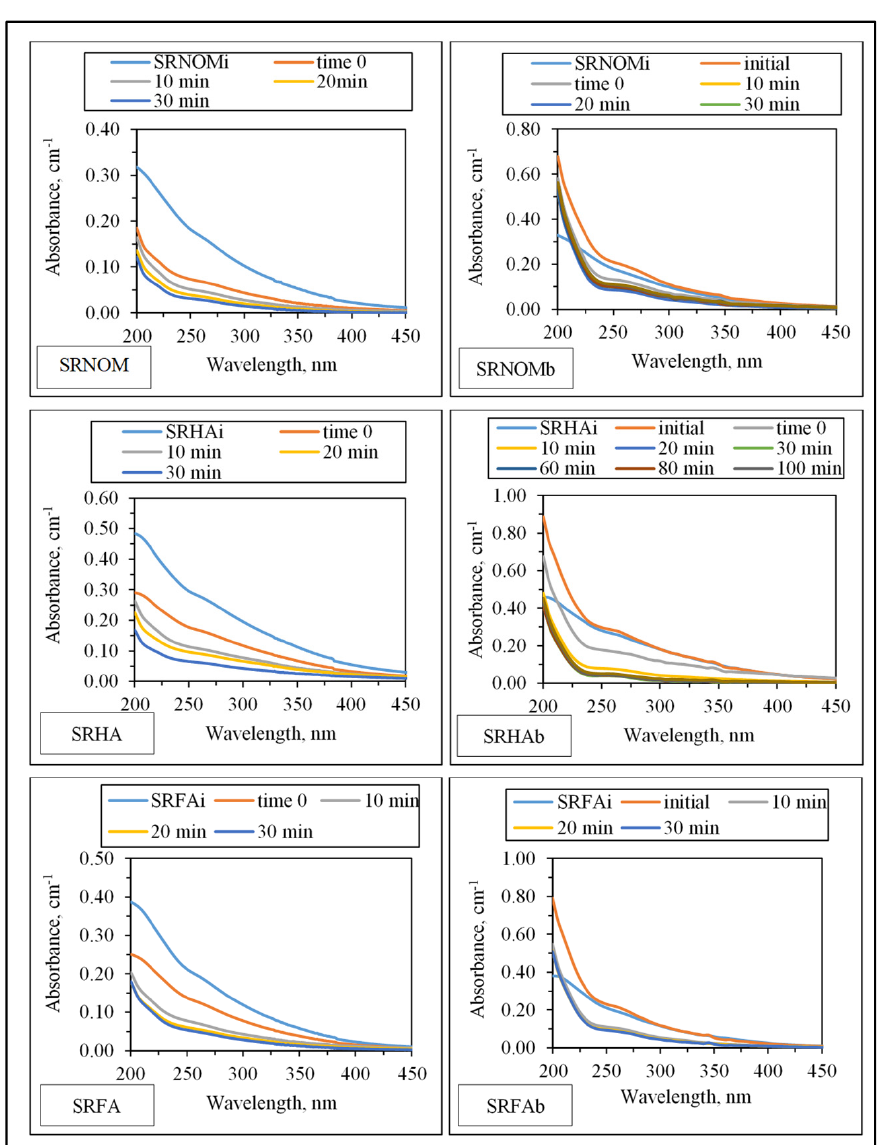
Figure 3. UV-VIS absorption spectral features of the organic matrix upon solar photocatalytic degradation of NOM compounds in the absence/presence of E. coli (b denotes the presence of bacteria). Insignificant absorbance values for λ > 400 nm indicated the absence of chromophoric groups (color-forming moieties) related to the presence of systems including conjugated double bonds, aromatic rings, and phenolic functional groups containing atoms with lone pairs of electrons. Initial conditions revealed the release of organics expressing a shoulder in the 240–280 nm wavelength range. Absorbance values at λ = 280 nm